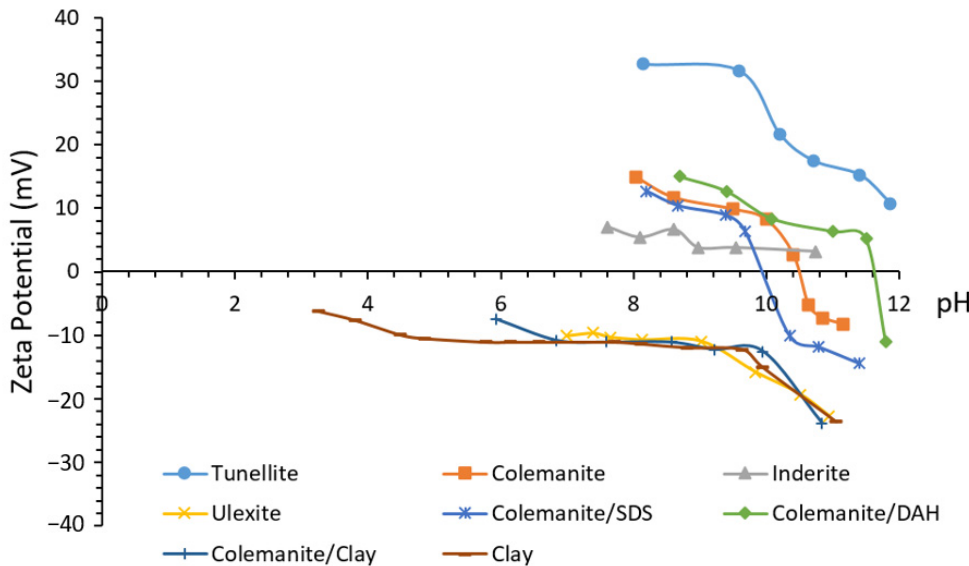
Figure 3. Zeta potential of boron minerals in the presence of clay and some flotation reagents [11,17,47].